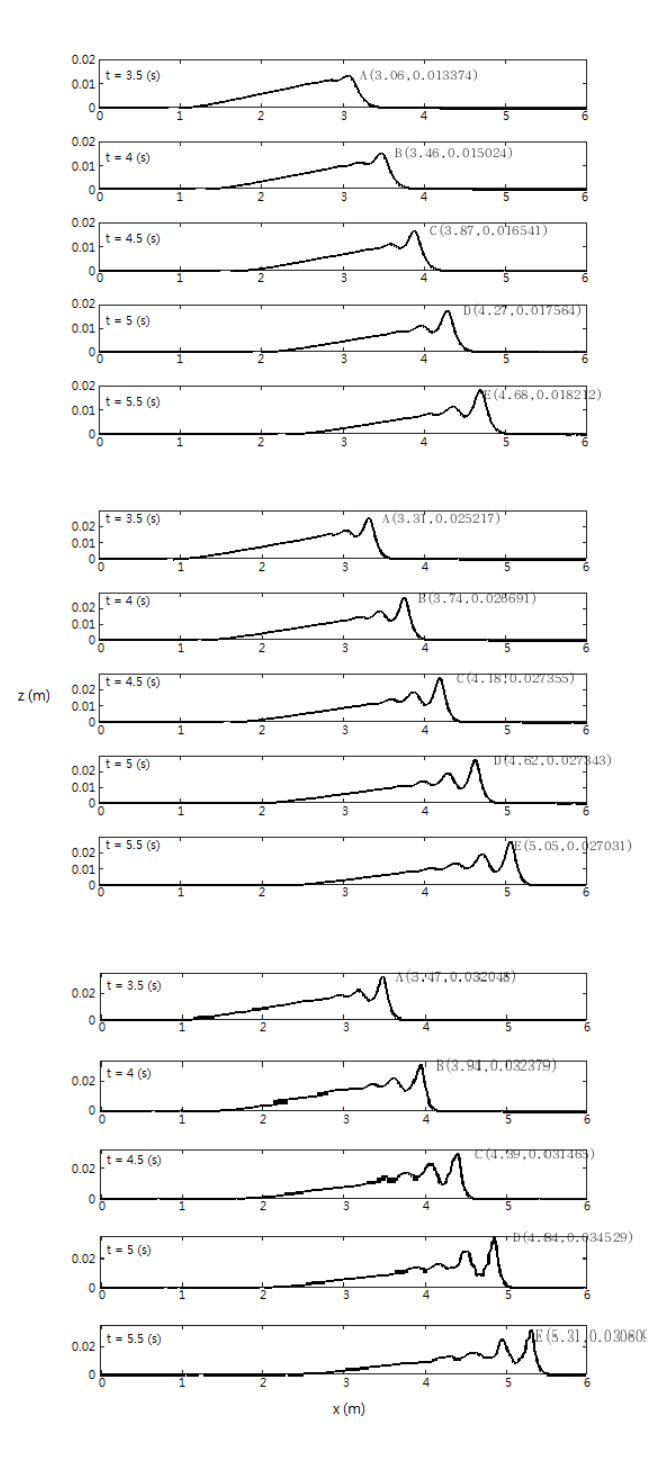
Figure 9. Profiles of leading elevation waves due to upward bottom motion with varying vertical wavemaker displacement, a , on a constant depth, h 0 . Top group a = 0.03 m; middle: a = 0.05 m; bottom a = 0.07 m. Values in the parentheses indicate (time, displacement) at each peak. In all cases, h 0 = 0.05 m, L = 1 cm, b = 0.5 s, and θ =